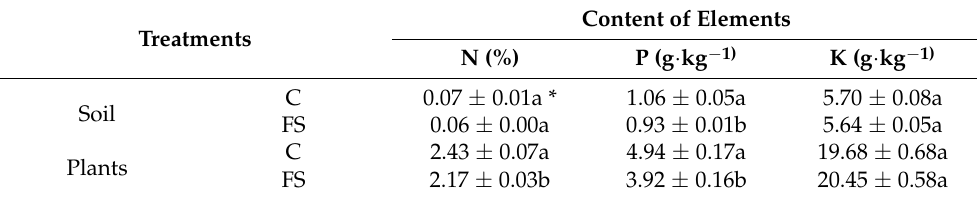
Table 2. Elements in soil and plants.